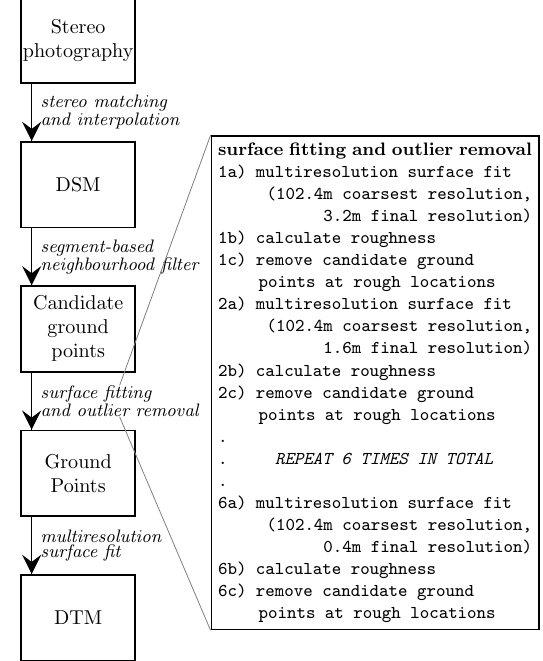
Figure 1. Complete work flow from stereo photography to